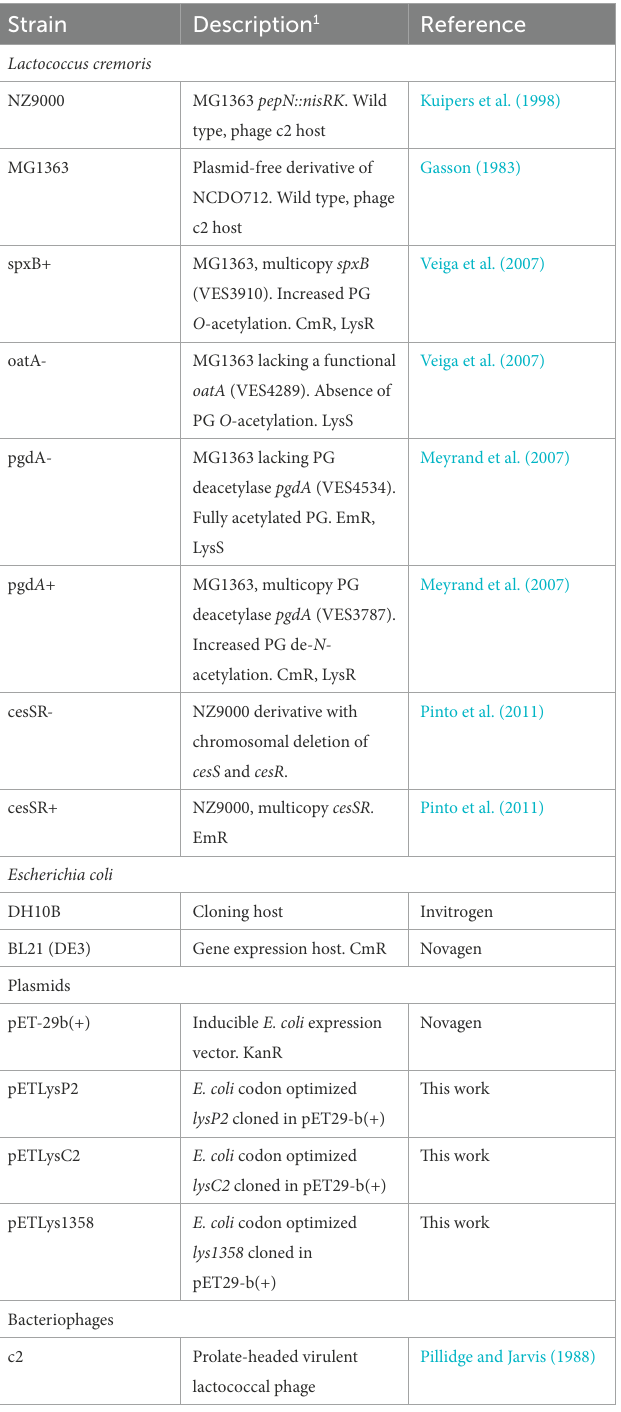
TABLE 1 Bacterial strains, plasmids, and bacteriophages used in this work.